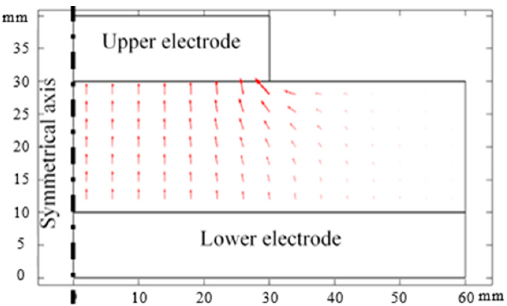
Figure 5. The magnitude and direction of DEP force on the abrasive between the upper and lower electrodes.